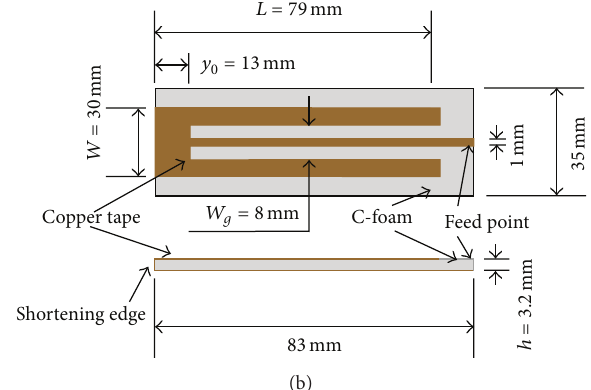
Figure 2: Structure of quarter-wave folded inset-fed rectangular patch antenna placed on silver fabric ground plane in three-dimensional view (a) and with dimensions (b).